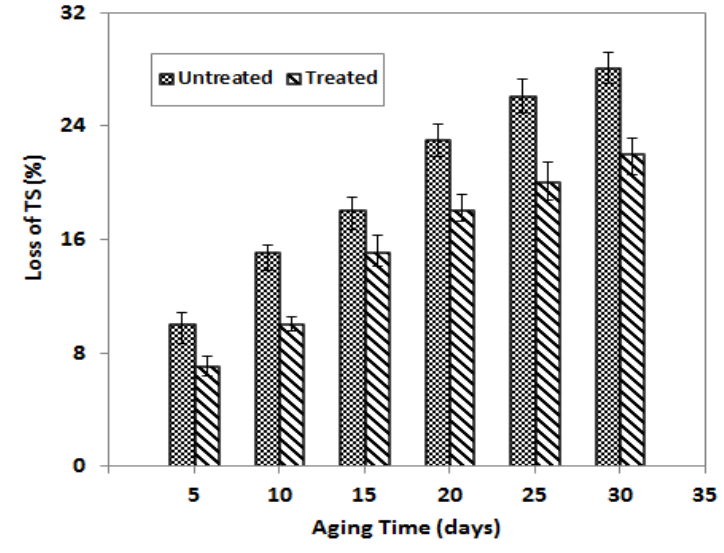
Figure 11: Loss of tensile strength of the optimized composites (45% fiber) against